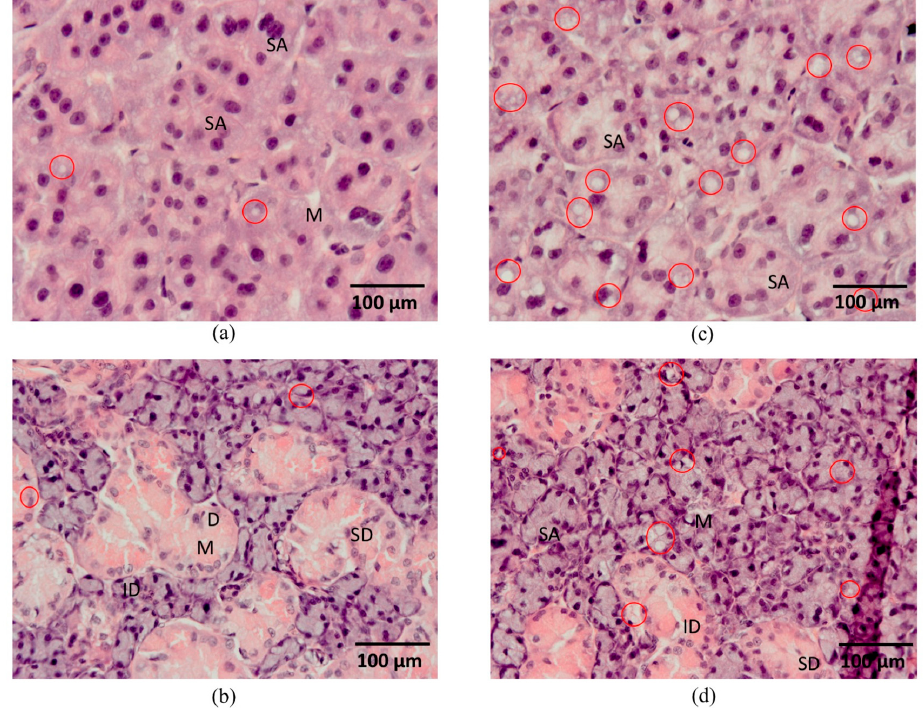
Figure 9. The influence of a high-sucrose diet (HSD) on histological observation of the salivary glands. Abbreviations: ( a ) parotid gland of the control rats, ( b ) submandibular gland of the control rats, ( c ) parotid gland of rats fed a high-sucrose diet (HSD), ( d ) submandibular gland of rats fed a high-sucrose diet (HSD), D, demilune, ID, intercalated ducts, M, mucous acini, SA, serous acini, SD, striated ducts.